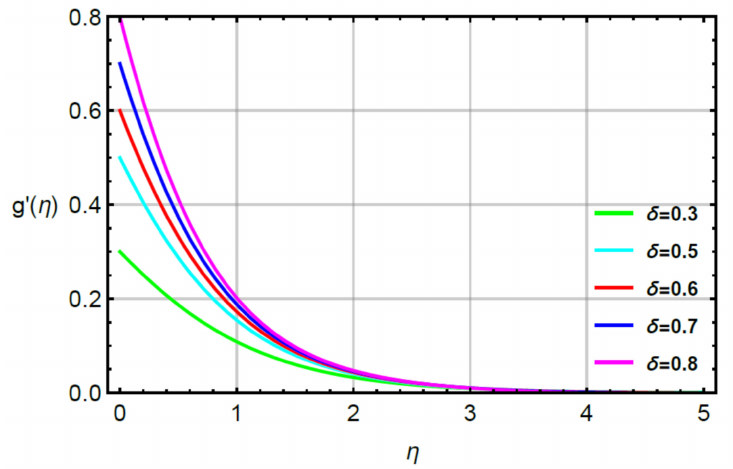
Figure 6. Behavior of g (cid:48) ( η ) for δ when R = 0.1, Sc = 0.6, Pr = 1.1, α 1 = 0.2 = α 2 , γ 1 = 0.3 = γ 2 , M =